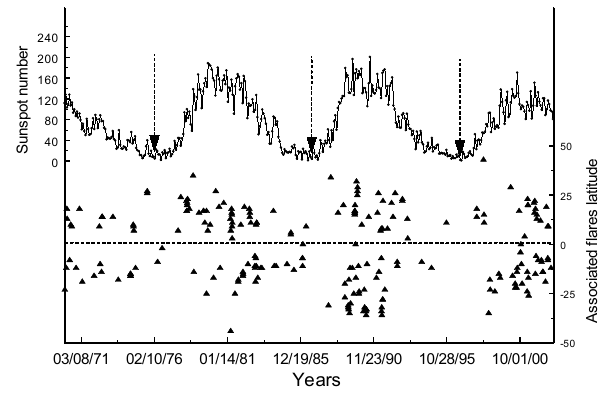
Fig. 5. “Butterfly diagram” of the associated with SPEs flares for the interval 1970–2002 is presented in the lower curve. Time profile of the sunspot number is also given in the upper curve.